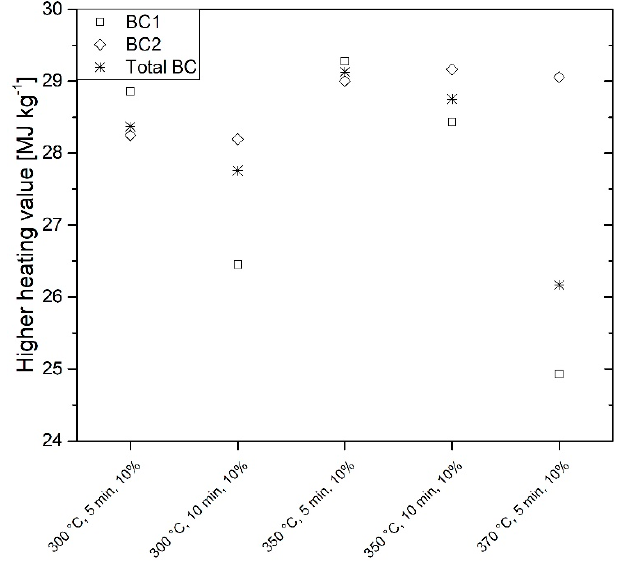
Figure 10. Higher heating value of light, heavy and total biocrude from the experiments carried out at 10% biomass-to-water mass ratio.